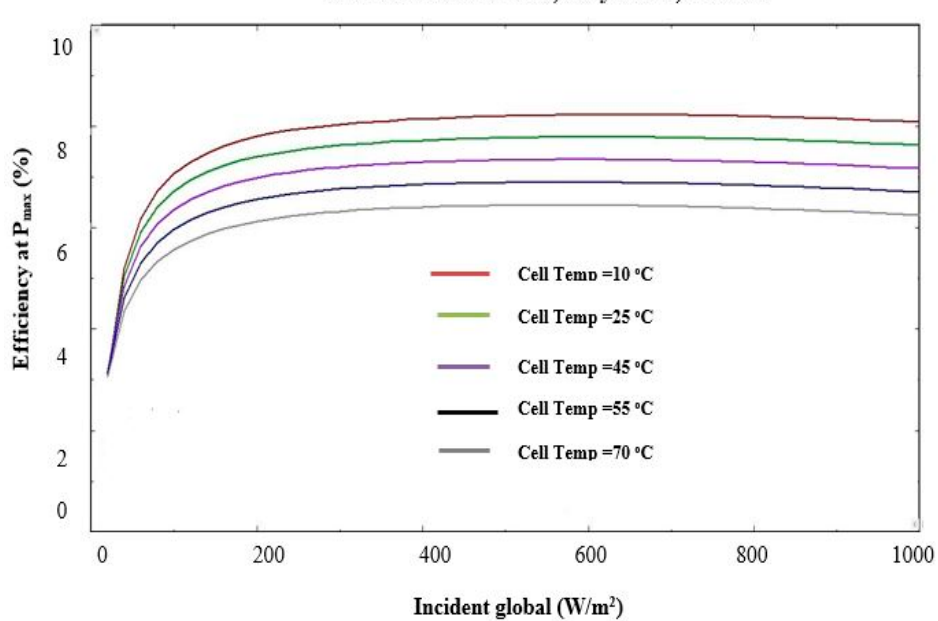
Figure 5. Effect of temperature on efficiency and global solar radiation (obtained from PVsyst soft- ware).